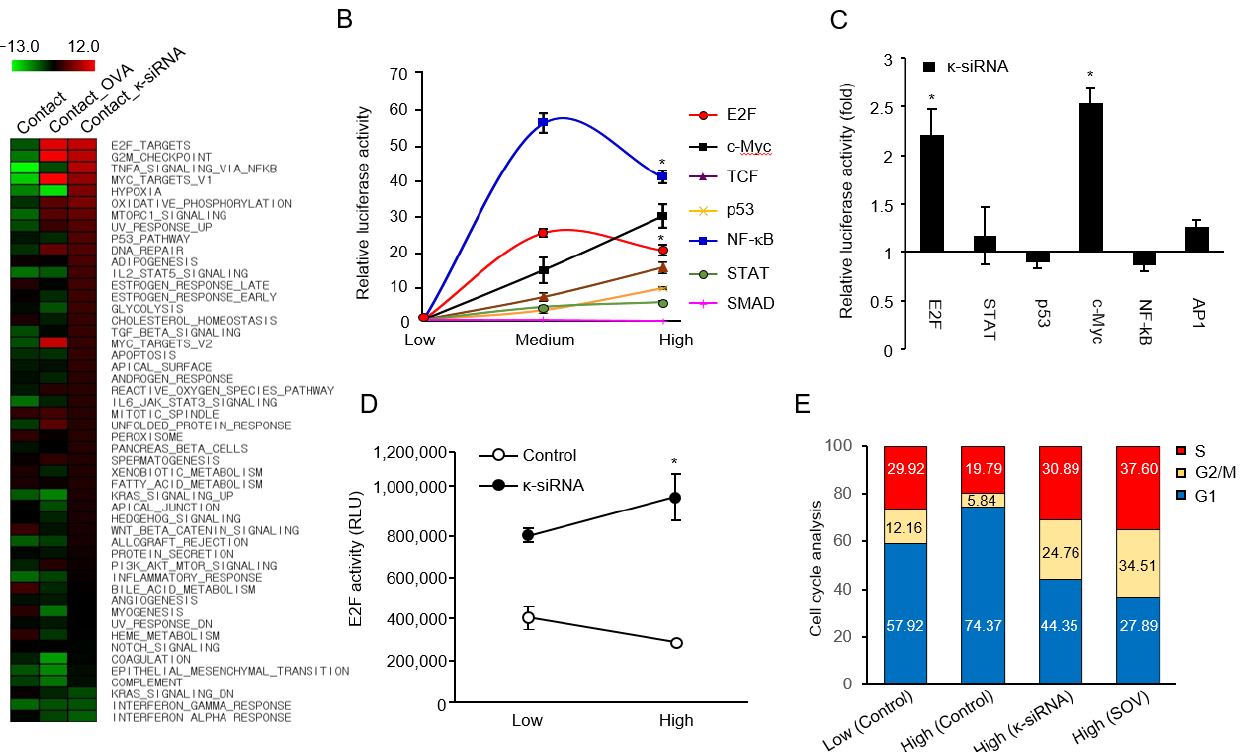
Figure 3. Analysis of growth-related signaling pathways in relation to cell density and R-PTP- κ expression level. ( A ) Functional enrichment analysis using 50 hallmark gene sets of gene expression profiles derived from RNA sequencing. ( B ) Activity profiles of growth-related signaling pathways under different cell-contact conditions. The activity was measured as firefly luciferase activity normalized by Renilla luciferase activity, an internal control for transfection efficiency. * p < 0.05. ( C ) Effect of R-PTP- κ knockdown on the activity of growth-related signaling pathway using luciferase reporter system. * p < 0.05. ( D ) Analysis of E2F activity in relation to plating cell density and R-PTP- κ expression. * p < 0.05. ( E ) Effect of R-PTP- κ on cell cycle progression. The cell cycle profile of siRNA- or SOV-treated HeLa cells was determined using flow cytometric analysis.